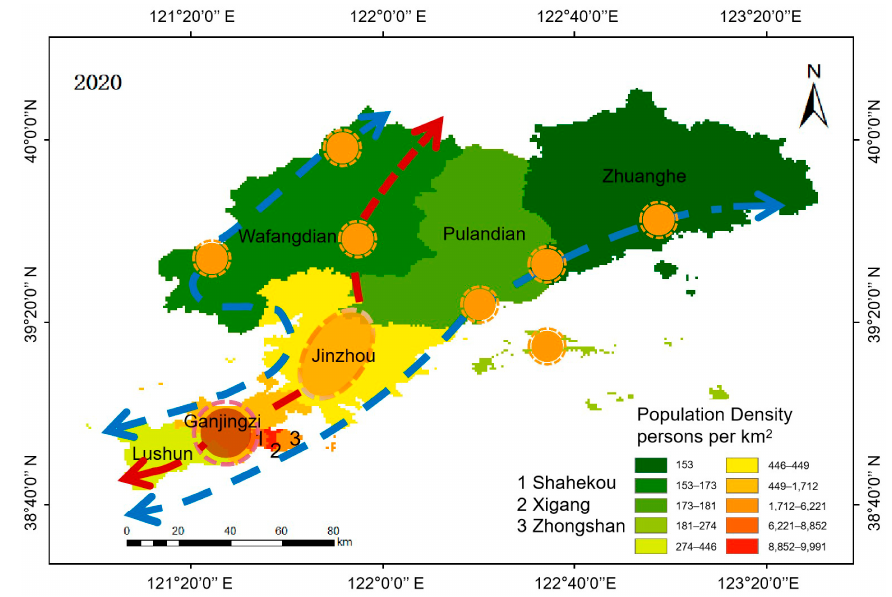
Figure 7. Population density distribution of Dalian in 2020. According to Formula (8), the number of neurons in the hidden layer of BPNN was determined to be between 2 and 12. After ten-fold cross-training, the average value of the RMSE of the verification set corresponding to the number of hidden layer neurons was obtained. The results of ten-fold cross-verification of training sets (a) to (f) are shown in Table 5. Compared with the number of iterations and learning rate, the selection of the number of hidden layer neurons has a great influence on the estimation accuracy, and the optimal hidden layer neurons of the six BPNN models (RMSEa–f) were determined to be 3, 2, 2, 2, 3, and 2, respectively. Table 5. Cross-validation training results of BPNN. Hidden Layer